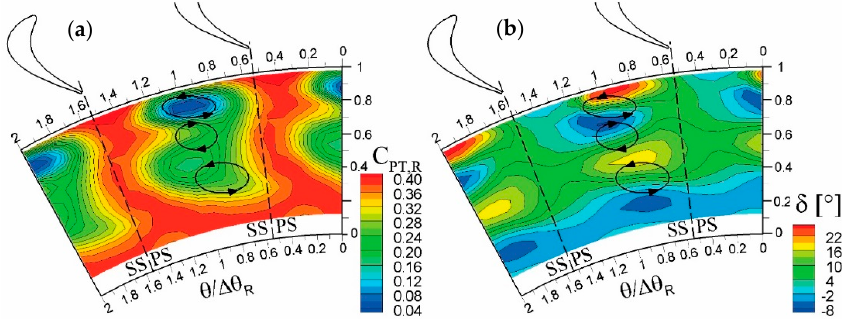
Figure 14. Rotor-exit relative flow field in OPLL, ( a ) relative total pressure coefficient; ( b ) deviation angle.